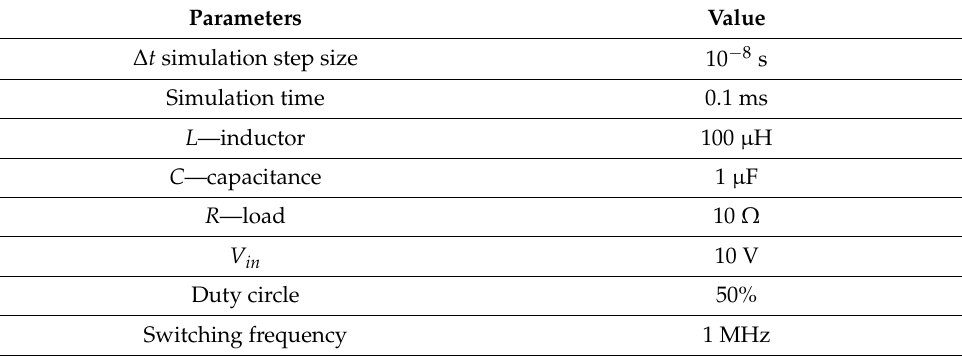
Table 1. Buck power stage and simulation